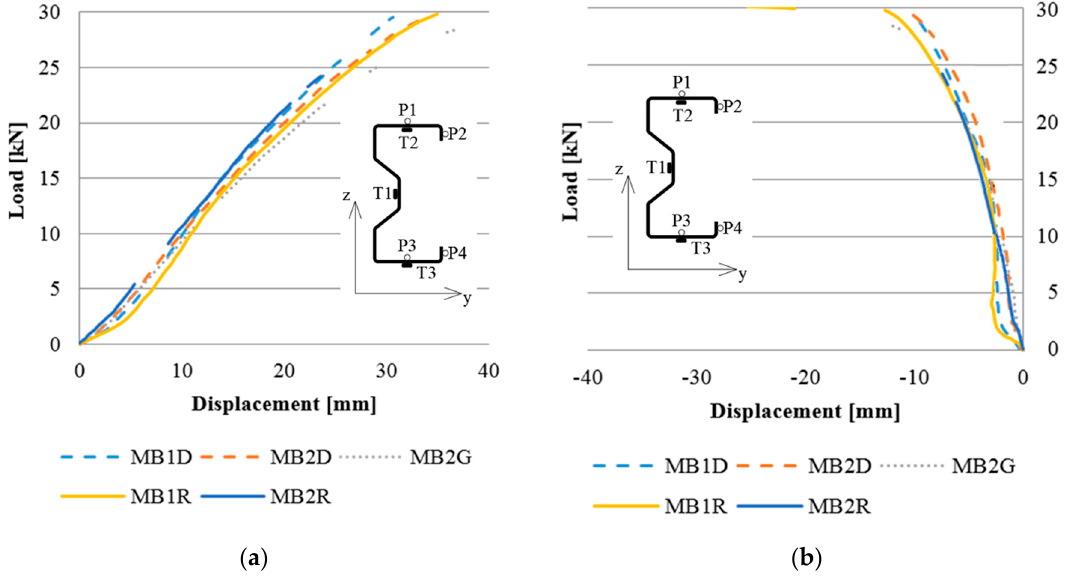
Figure 9. Load–displacement correlation measured at point P2 in the ( a ) vertical direction (z), ( b ) horizontal direction (y).